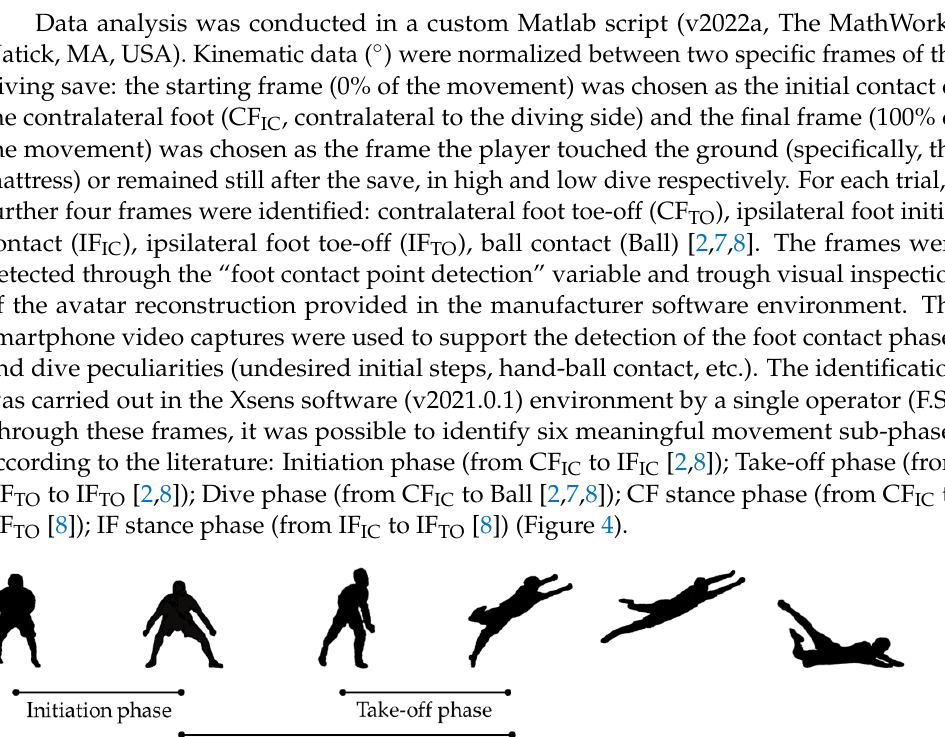
Figure 3. Sensor placement — bilaterally on feet (middle bridge); shanks (shin bone); thighs (lateral side); shoulders (scapulae); arms (lateral above elbow); forearms (lateral below elbow); hands (back- side); pelvis (sacrum); trunk (sternum); head.